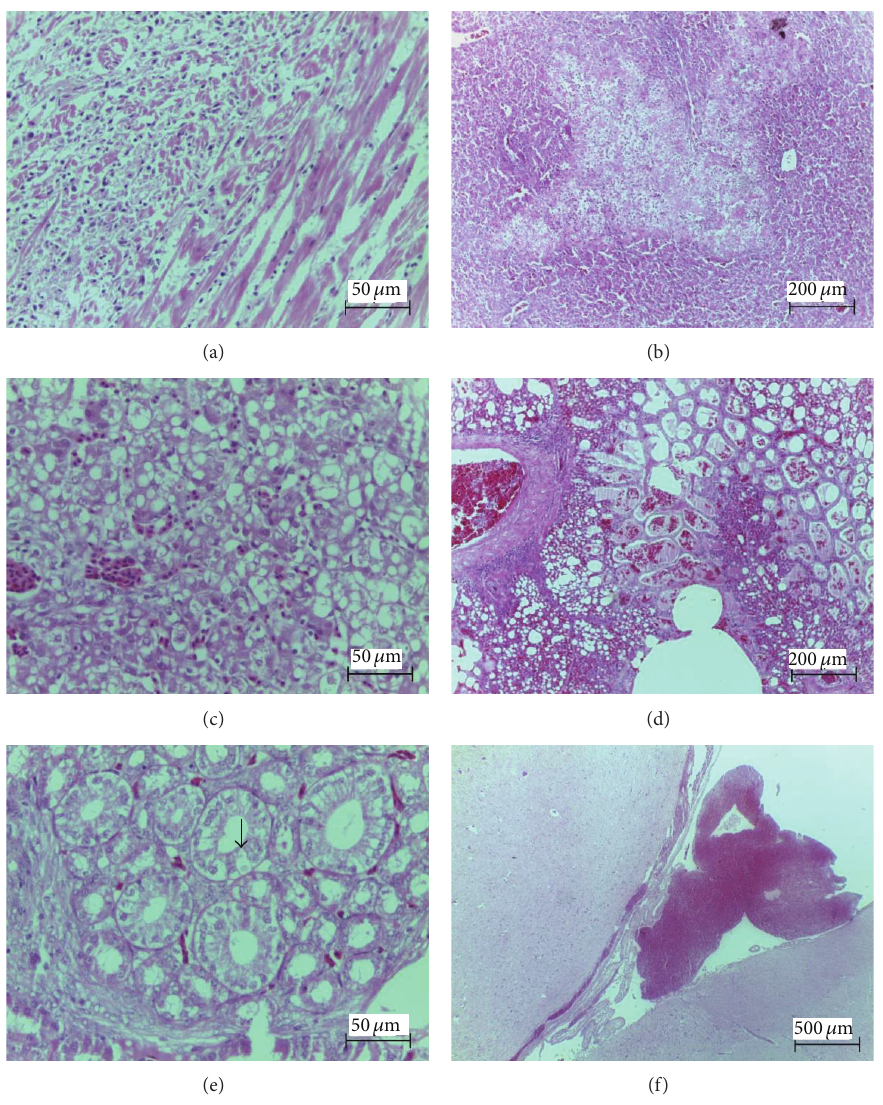
Figure 2: Histopathological changes in chicks treated with Rhinella jimi venom. (a) Extensive foci of necrotic cardiac fibers (H&E, Bar = 50 𝜇 m). (b) Liver section showing hepatocyte necrosis (H&E, Bar = 200 𝜇 m). (c) Focal areas of hemorrhage in the hepatic parenchyma (H&E, Bar = 50 𝜇 m). (d) Lungs section showing moderate acute diffuse alveolar hemorrhage (H&E, Bar = 200 𝜇 m). (e) Vacuolar degeneration of the renal tubular epithelium (arrow) and multifocal areas of hemorrhage in the interstitium of the renal cortex (H&E, Bar = 50 𝜇 m). (f) Brain section showing extensive subdural hemorrhage (H&E, Bar = 200 𝜇